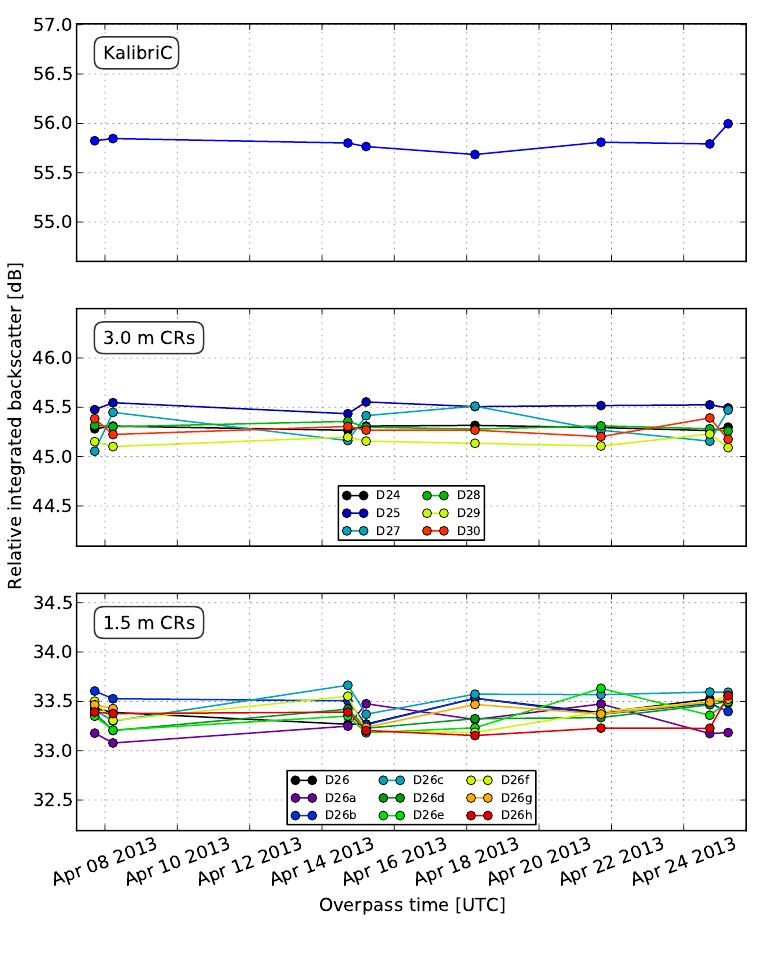
Figure 12. Measured impulse response powers with RADARSAT-2 drift compensation (see Figure 11) applied. The dispersion within one target group is now greatly reduced with respect to Figure